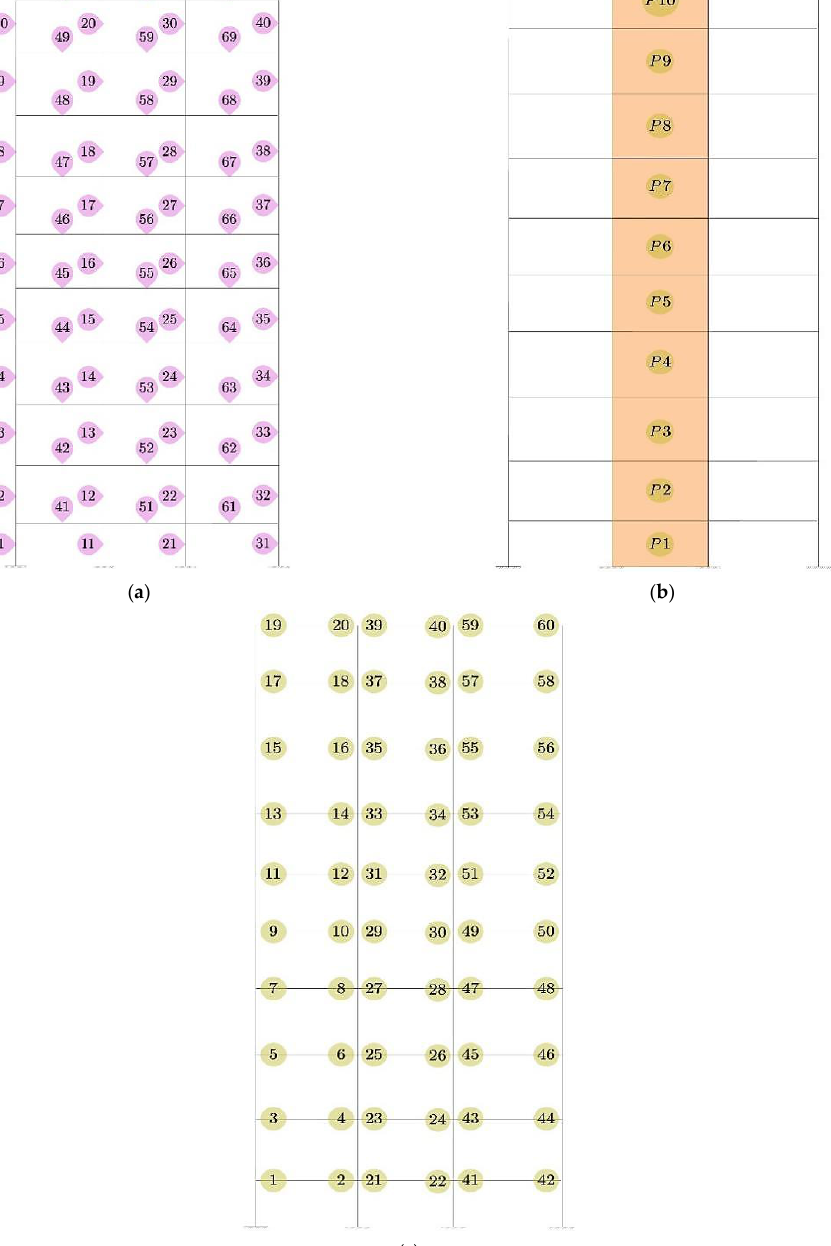
Figure 15. ( a – c ). Dimensions of the three-bay, ten-story structure and the infilled plates ’ placement. The portion of the final results is given in Table 5.